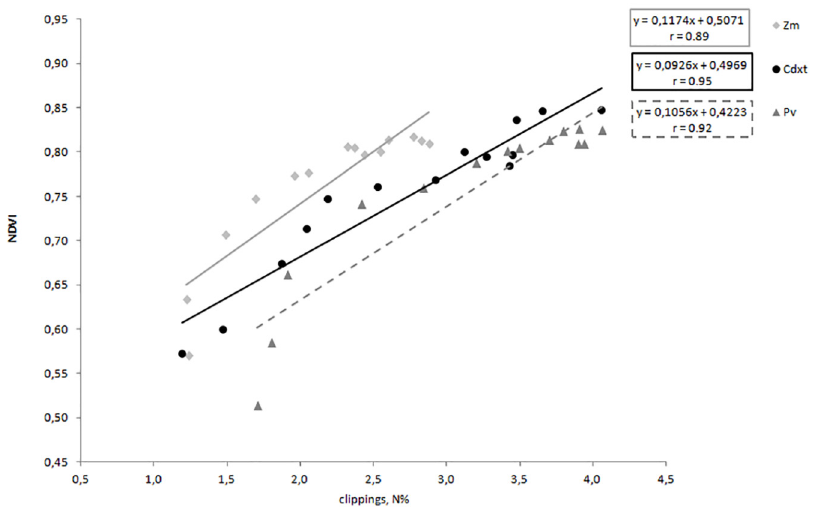
Fig 6. Relationships between the clippings nitrogen content and NDVI data measured with the UAV on Cynodon dactylon x transvaalensis , Paspalum vaginatum and Zoysia matrella . In each species values are means of 4